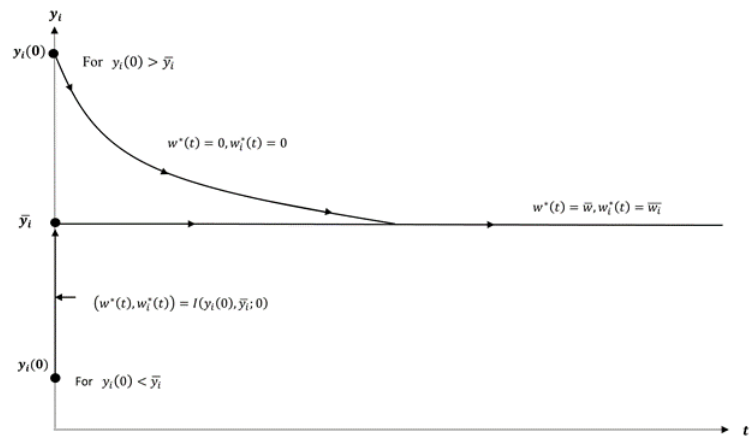
Figure 1. Optimal advertising effort policy for two initial conditions.